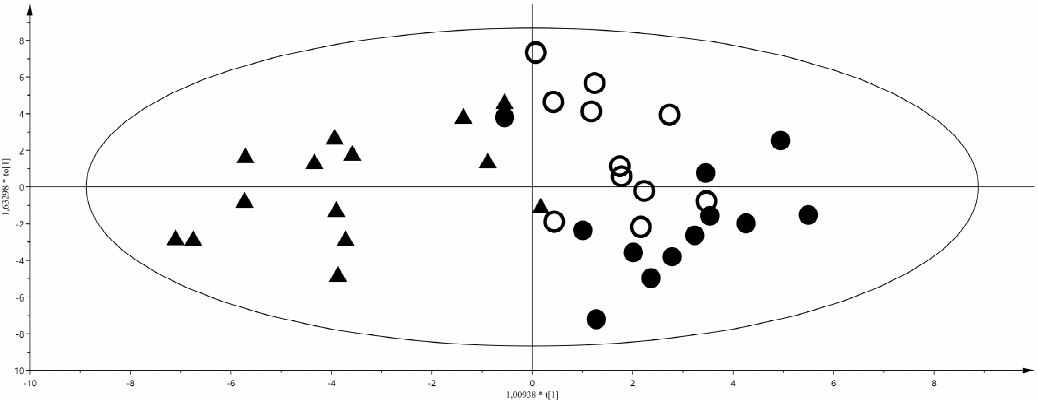
Figure 2. Orthogonal partial least square discriminant analysis (OPLS-DA) of appropriate gestational age (AGA) vs. intrauterine growth restriction (IUGR) + large for gestational age (LGA) neonates at birth, R 2 Y = 0.71, Q 2 Y = 0.36. Score plot, triangles represent the AGA class, filled and empty circles LGA and IUGR, respectively. Separation of classes is maximized through the predictive component ( x -axis), intraclass variability is described through the orthogonal component ( y -axis).